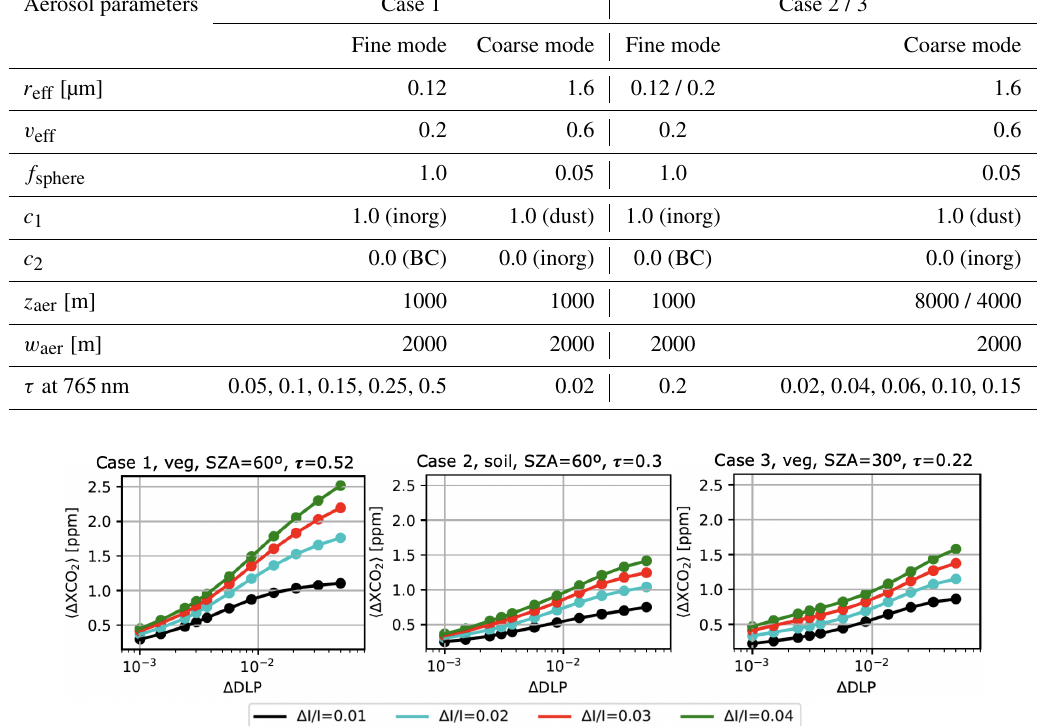
Table 4. Aerosol properties adopted in the study cases.